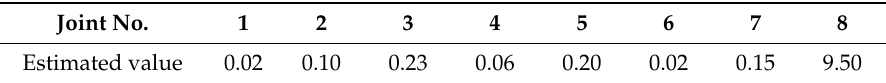
(cid:2) 10 6 Nm/rad